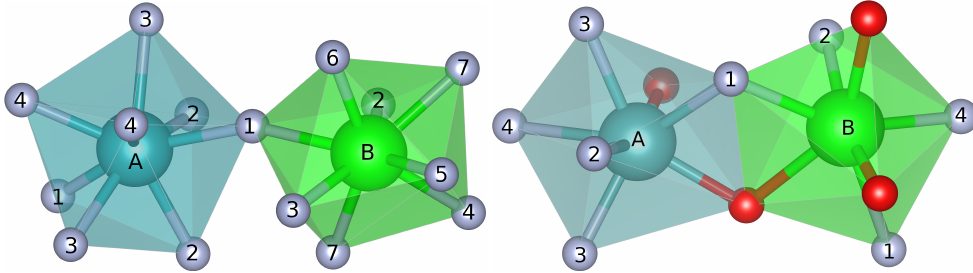
Figure 3. Visualization of the two distinct coordination polyhedrons A and B found in MF 4 ( left ) and MOF 2 ( right ). The non-symmetry equivalent fluorine atoms are labeled accordingly.